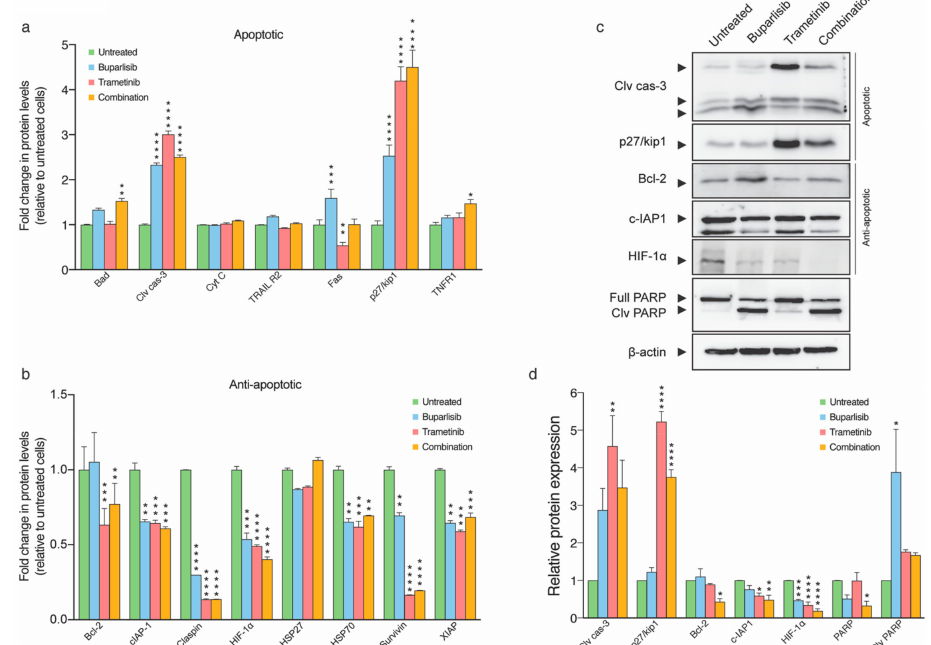
Figure 6. Expression of apoptosis associated proteins after treatment of H1 cells with 10 µ M buparlisib, 25 nM trametinib or a combination (5 µ M buparlisib + 12.5 nM trametinib). ( a ) graphic presentation of results from the apoptosis array, showing expression of key molecules involved in apoptosis in H1 cells treated with 20 µ M buparlisib, 50 nM trametinib, or 10 µ M buparlisib + 25 nM trametinib, for 72 h; ( b ) graphic representation of key molecules involved in anti-apoptotic activity in H1 cells after buparlisib and trametinib treatment; ( c ) Western blots showing the expression of selected apoptotic and anti-apoptotic proteins in addition to PARP; ( d ) quantification of Western blot results relative to β -actin. Abbreviations: Clv cas-3: cleaved caspase-3, cyt C: cytochrome C, full: full length PARP, clv: cleaved, *: p < 0.05, **: p < 0.01, ***: p < 0.001 and ****: p <